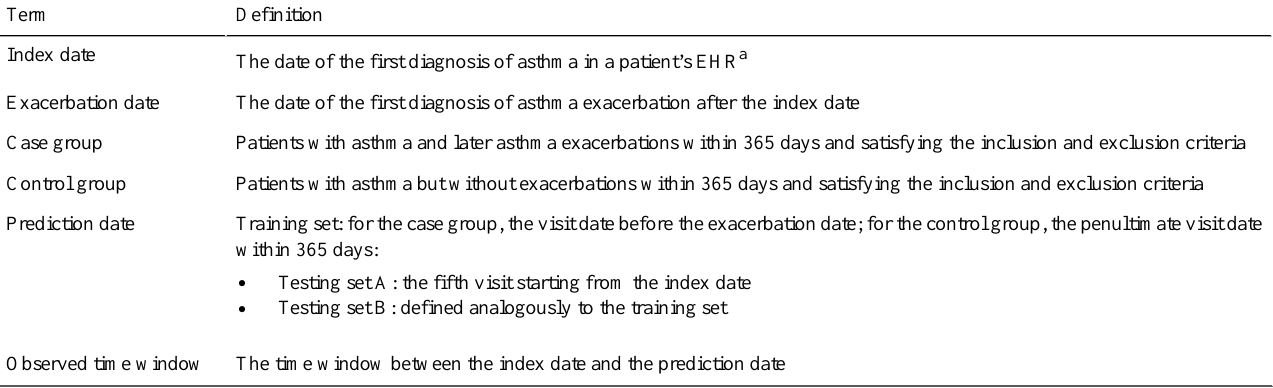
Table 1. Defined terms for asthma exacerbation